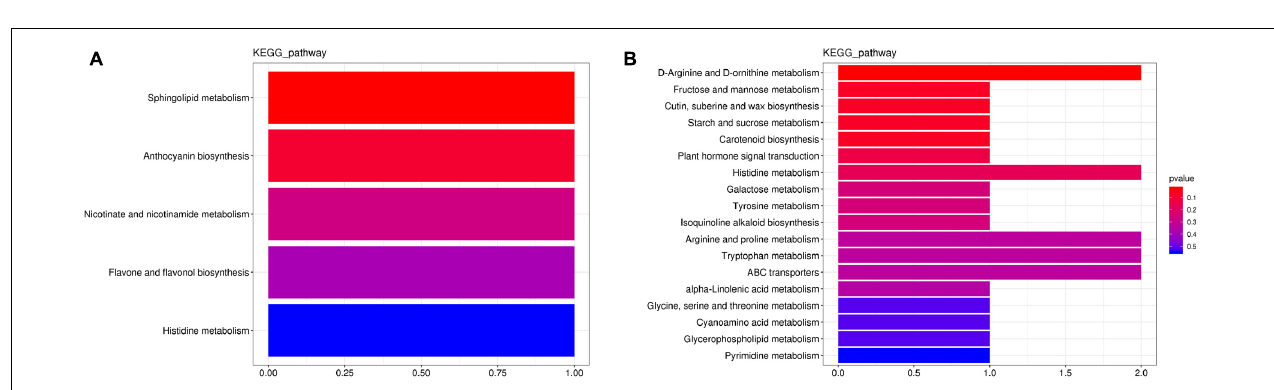
FIGURE 3 | Score scatterplots of OPLS-DA (A,C) and validation plots (B,D) for two comparative groupings: CK vs. B, and D vs. DB.